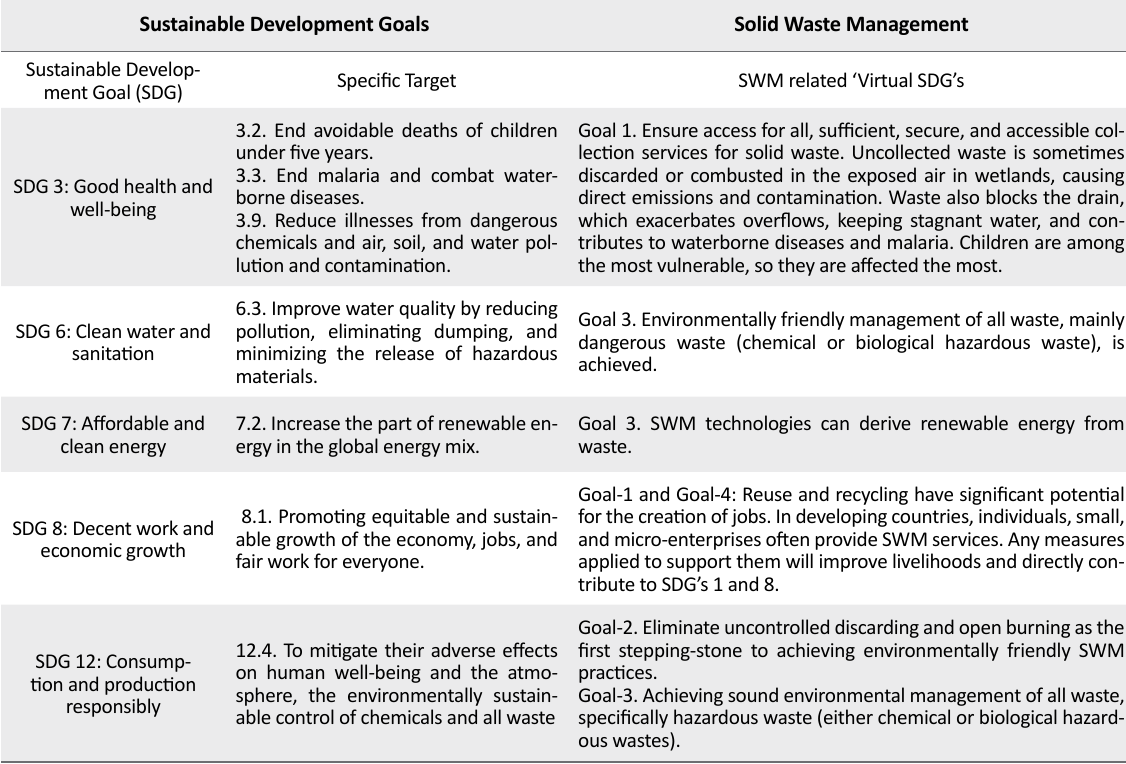
Table 1. Relationship between Sustainable Development Goals (SDGs) and Solid Waste Management (SWM) [6, 7] Sustainable Development